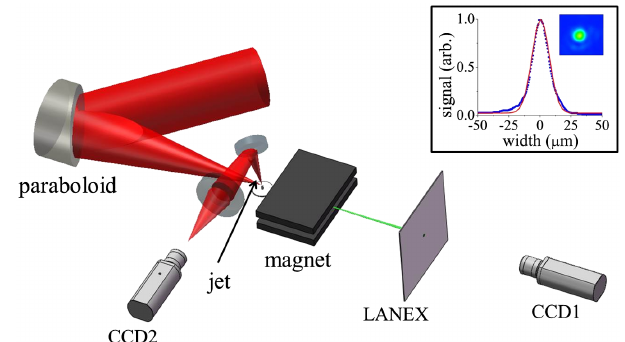
FIG. 1. Schematic of the experimental setup. The laser pulse is focused at the front edge of a supersonic helium gas jet. Pulse propagation is monitored by imaging the Thomson-scattered light using CCD2. Electrons passing through a magnetic spec- trometer impinge on a LANEX screen. Optical emission from the LANEX is imaged onto CCD1 to measure the beam angular divergence and energy spectrum. Inset: image of the laser focal spot in vacuum (full-power shot) and its vertical (blue/dark gray) and horizontal (red/light gray)